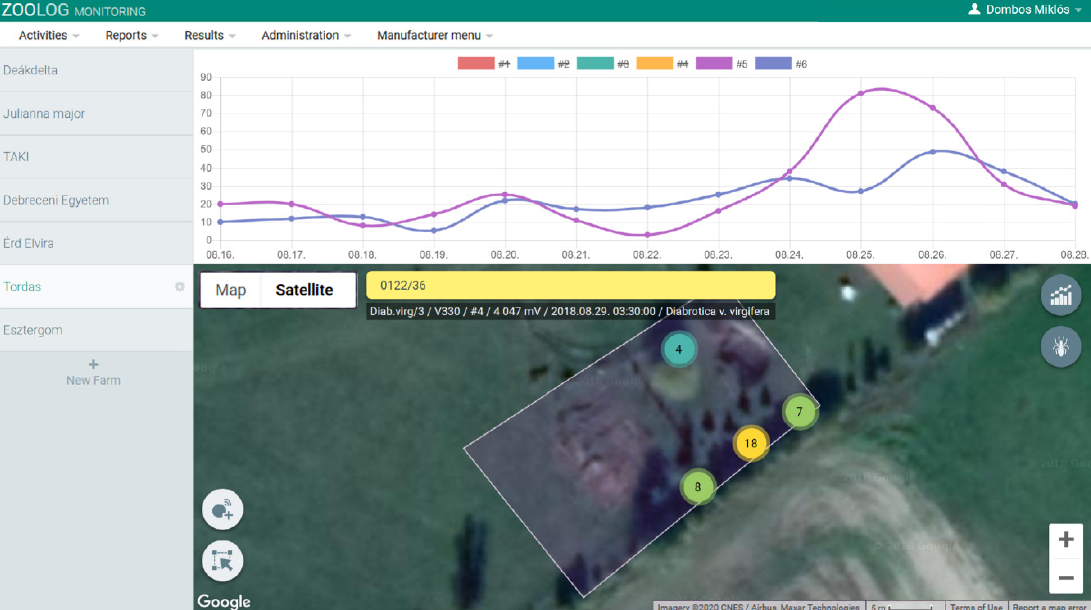
Figure 2. The ZooLog Online Web Interface: The monitoring system provides daily data via the internet. The probes and their status are visualized on a map. This interface is also used for setting the probes and data filtering. Results of the detection data can be downloaded and automatically visualized as graphs, typically the number of detected insects per day. Table 1. The geographical location of the test sites and ZooLog KLP